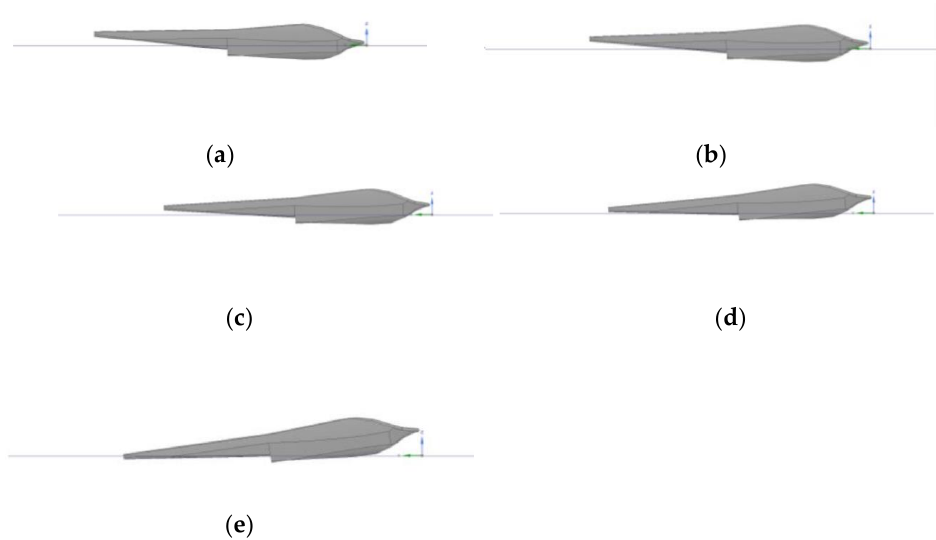
Figure 2. Initial float with variations of stern trim: ( a ) 0.44 degree; ( b ) 0.88 degree; ( c ) 1.32 degree; ( d ) 1.76 degree; ( e ) 2.2 degree.